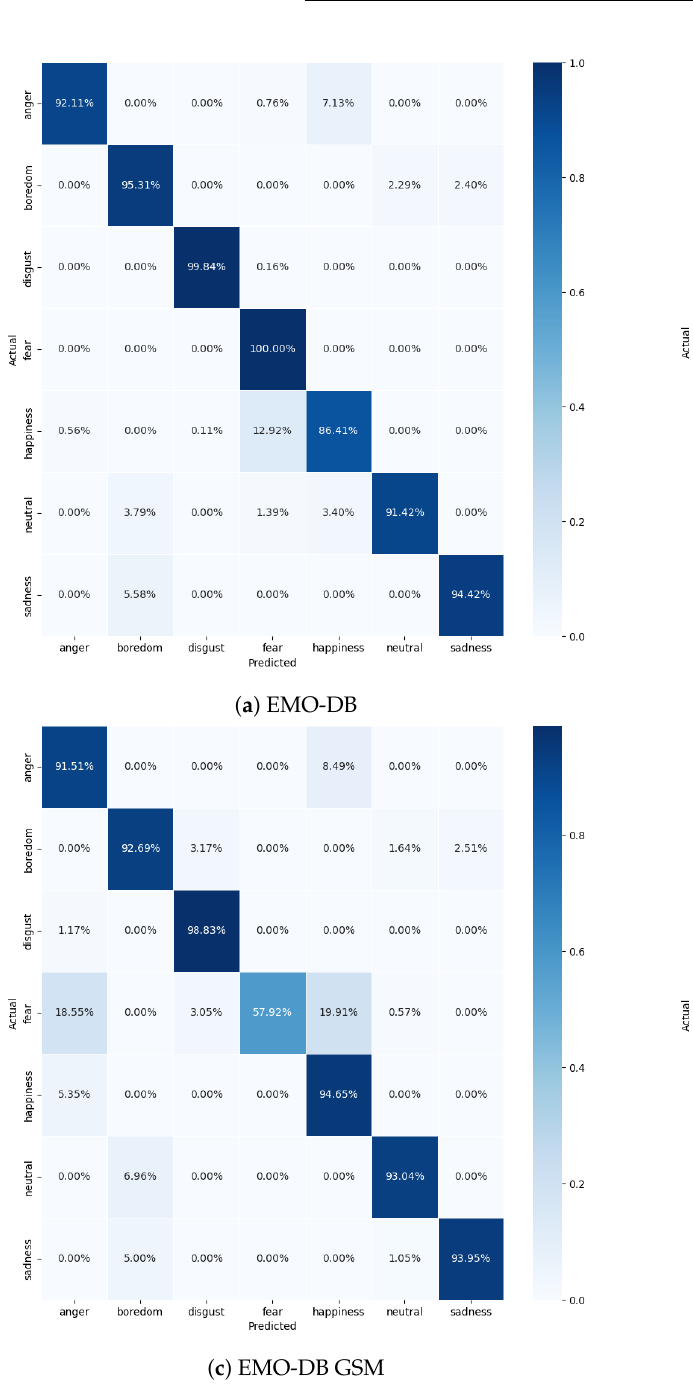
Figure 10. Confusion matrices for both normal and GSM-like coded